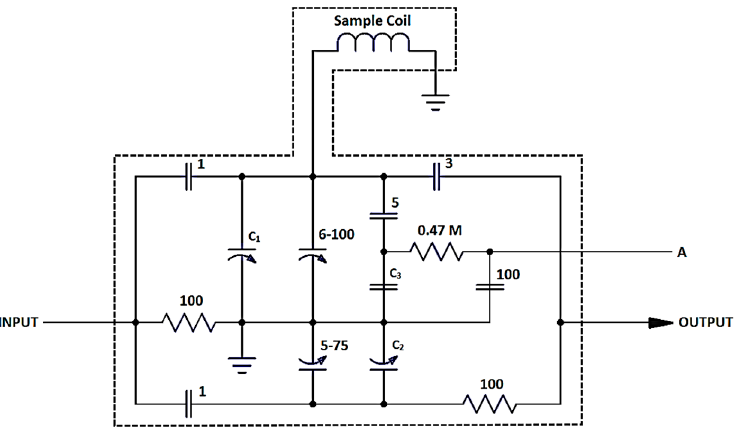
Figure 3. An example of automatic bridge circuit balancing (Correction voltage applied through A).